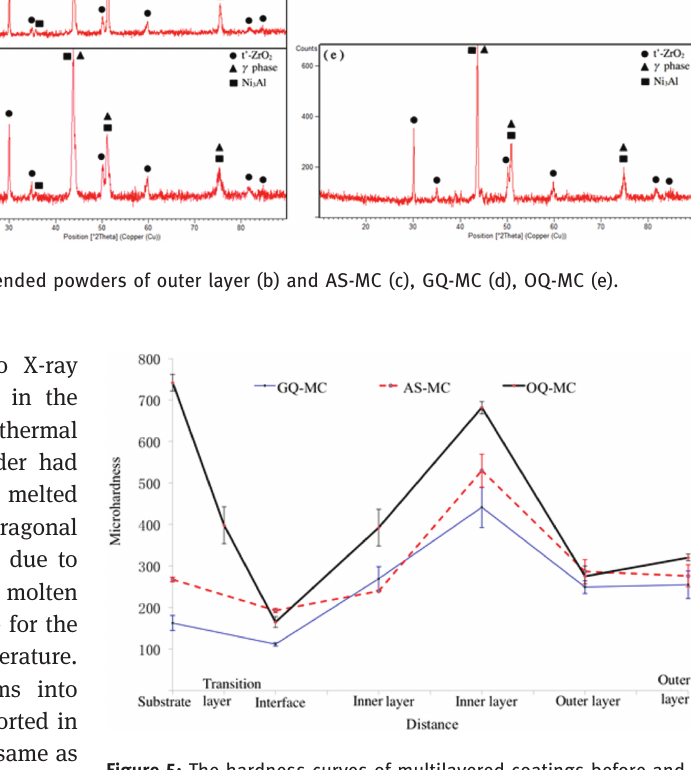
Figure 5: The hardness curves of multilayered coatings before and after heat